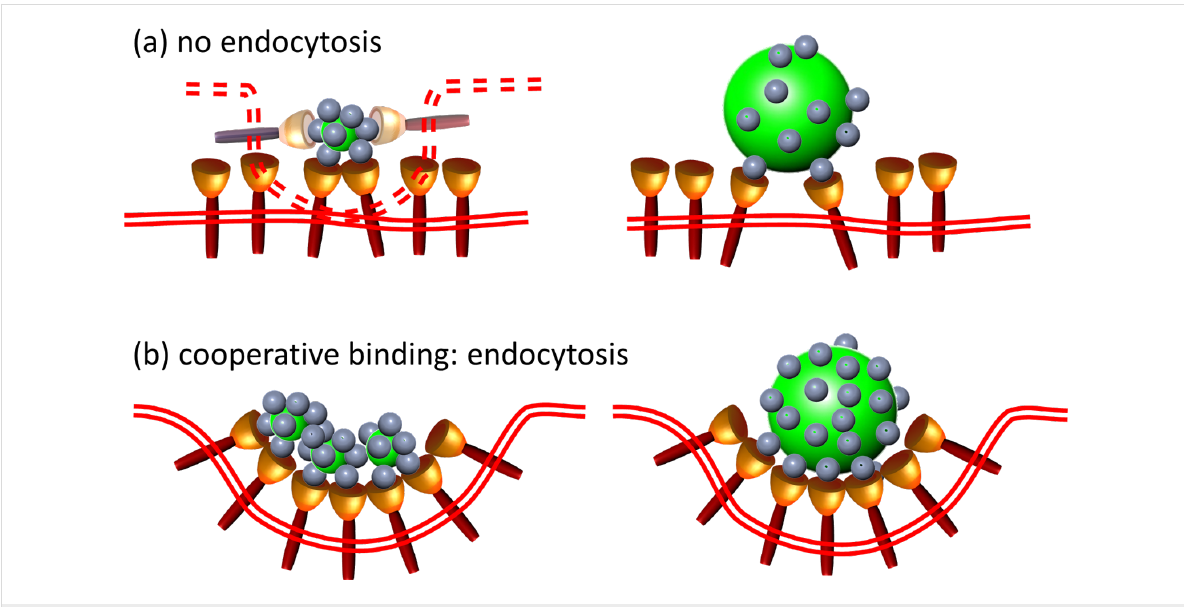
Figure 5: Schematic depiction of the interplay between membrane receptors (depicted as cups) and NP surface ligands (depicted as gray spheres). (a) The number of ligands offered to the receptors is insufficient to induce invagination, either because (left) the NP or (right) the density of functional groups is too small. To allow for a sufficiently large number of ligand–receptor interactions, an extreme (and unrealistic) membrane curvature (dashed) would be required. (b) The number of successful receptor interactions can be increased by either clustering small NPs or having high densi- ties of functional groups on larger